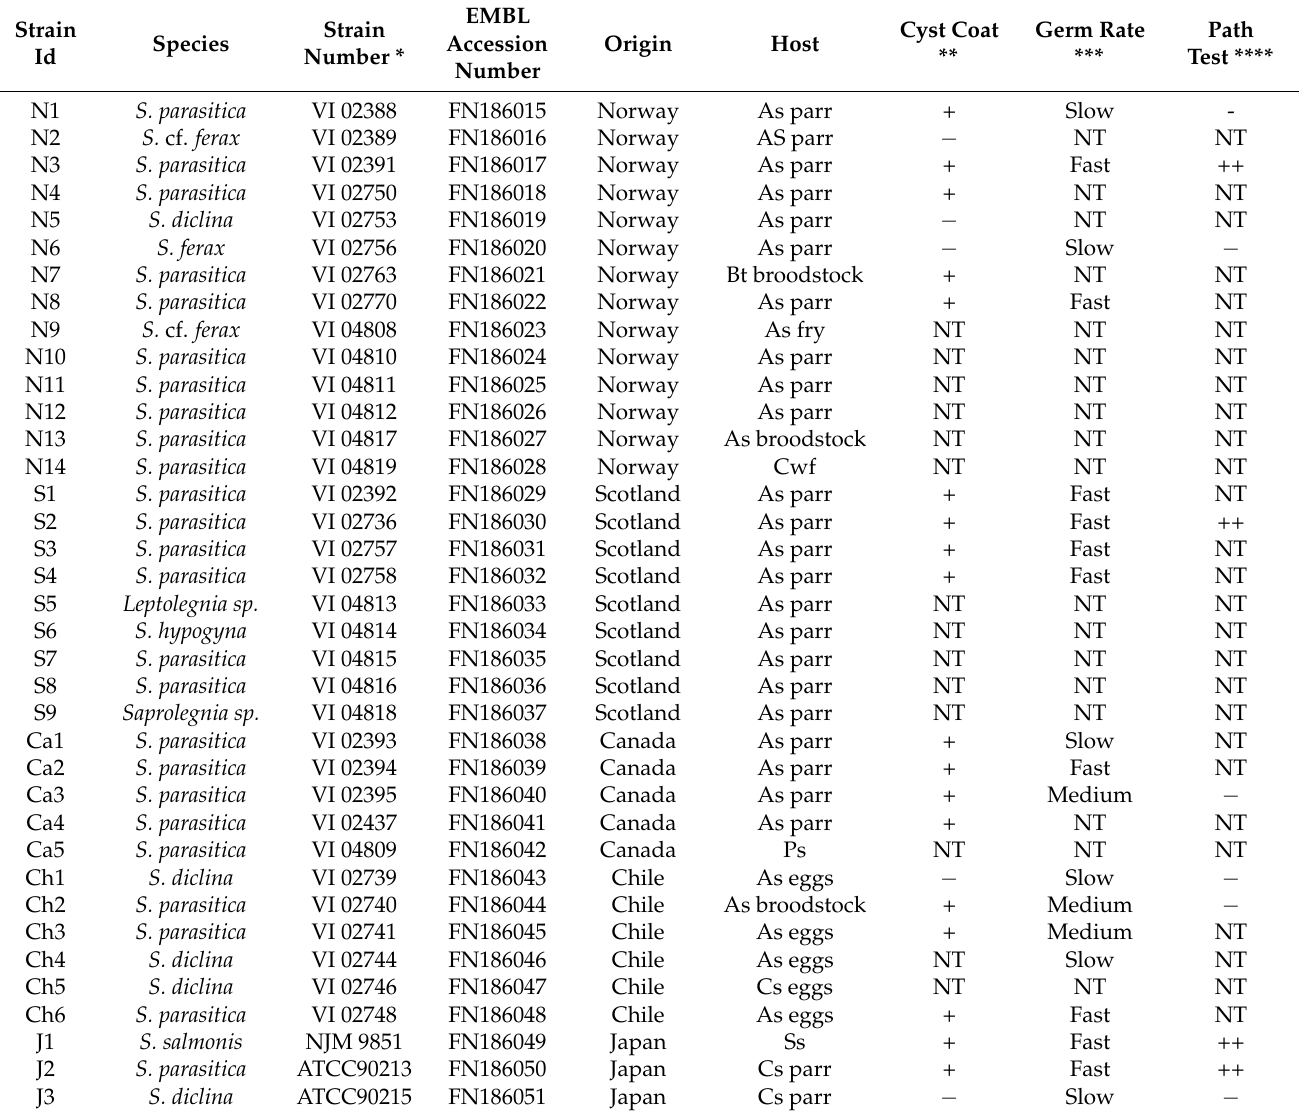
Table 1. The Saprolegnia isolates included in the study collected from Canada, Chile, Japan, Norway and